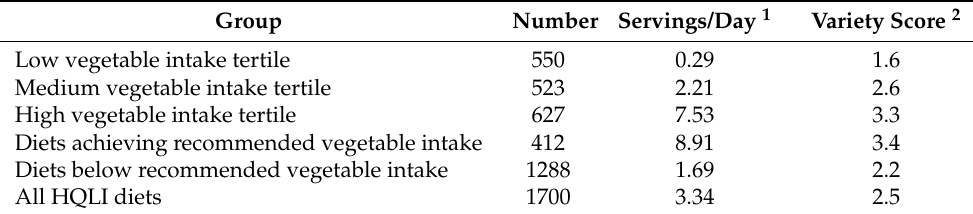
Table 3. The higher diet quality/lower environmental impact (HQLI) subgroup of adult (19 years old and above) daily diets in Australia: vegetable intake and variety